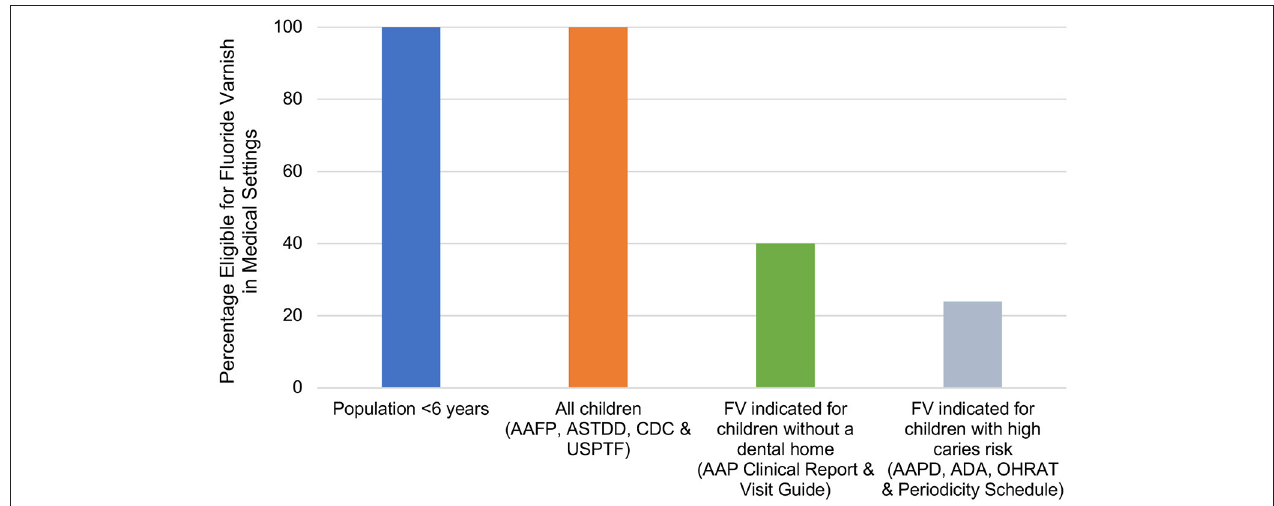
FIGURE 1 | Estimated percentage of the population younger than 6 years of age eligible for fluoride varnish in medical settings by guideline. Estimates of children without a dental home were based on the 2016 MEPS, which found that about 60% of children aged 2–5 years had a dental visit in the past year (21). Estimates for children with high caries risk were based on the 2011–2014 NHANES, which found that about 24% of children aged 2–5 years had dental caries (20). AAFP, American Academy of Family Physicians; AAP American Academy of Pediatrics; AAPD, American Academy of Pediatric Dentistry; ADA, American Dental Association; ASTDD, Association of State and Territory Dental Directors; CDC, Centers for Disease Control and Prevention; OHRAT, Oral Health Risk Assessment Tool (AAP); USPSTF, U.S. Preventive Services Task Force.